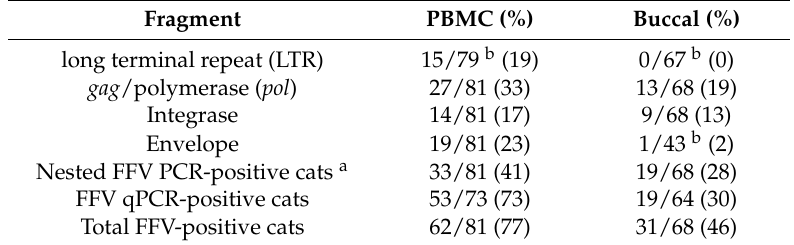
Table 4. Nested FFV PCR detection in peripheral blood mononuclear cells (PBMC) and buccal